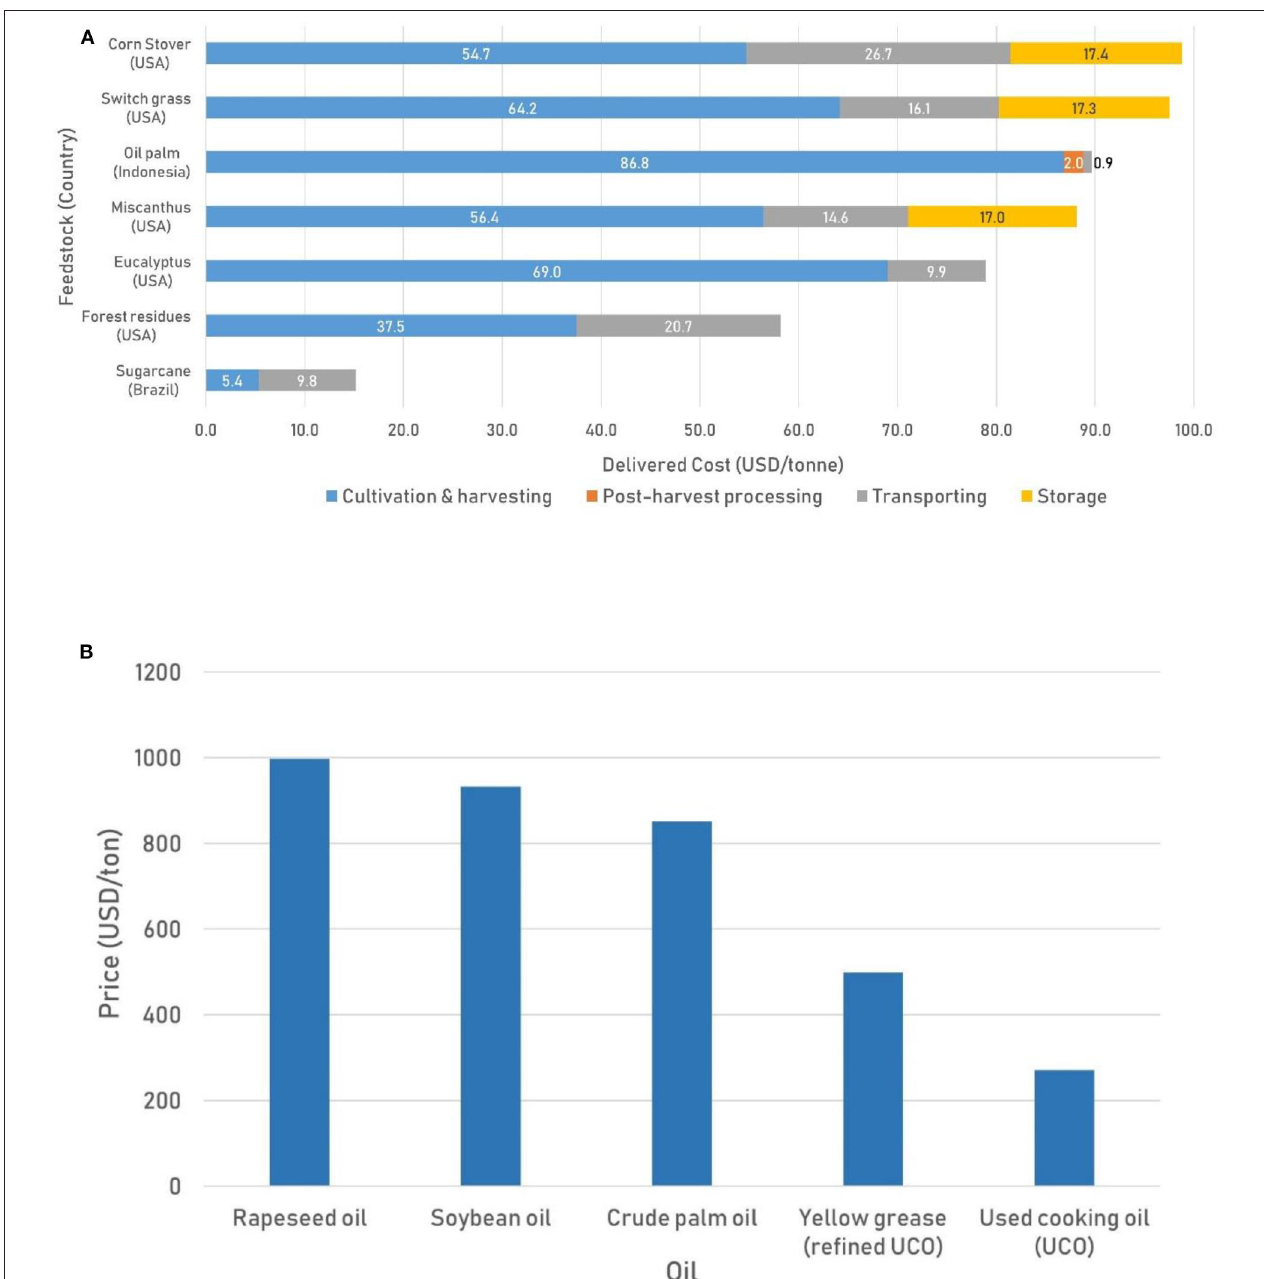
FIGURE 3 | Typical economic impacts (adjusted to 2019 levels) of some 1-G and 2-G feedstocks for BAF production: (A) Delivered (farm-to-gate) cost (Plotted using data from Gonzalez et al., 2011a; Gonzales et al., 2013; de Castro et al., 2018; Harahap et al., 2019); and (B) Average market price of fresh edible and waste oils (Plotted using data from Mandolesi de Araújo et al.,